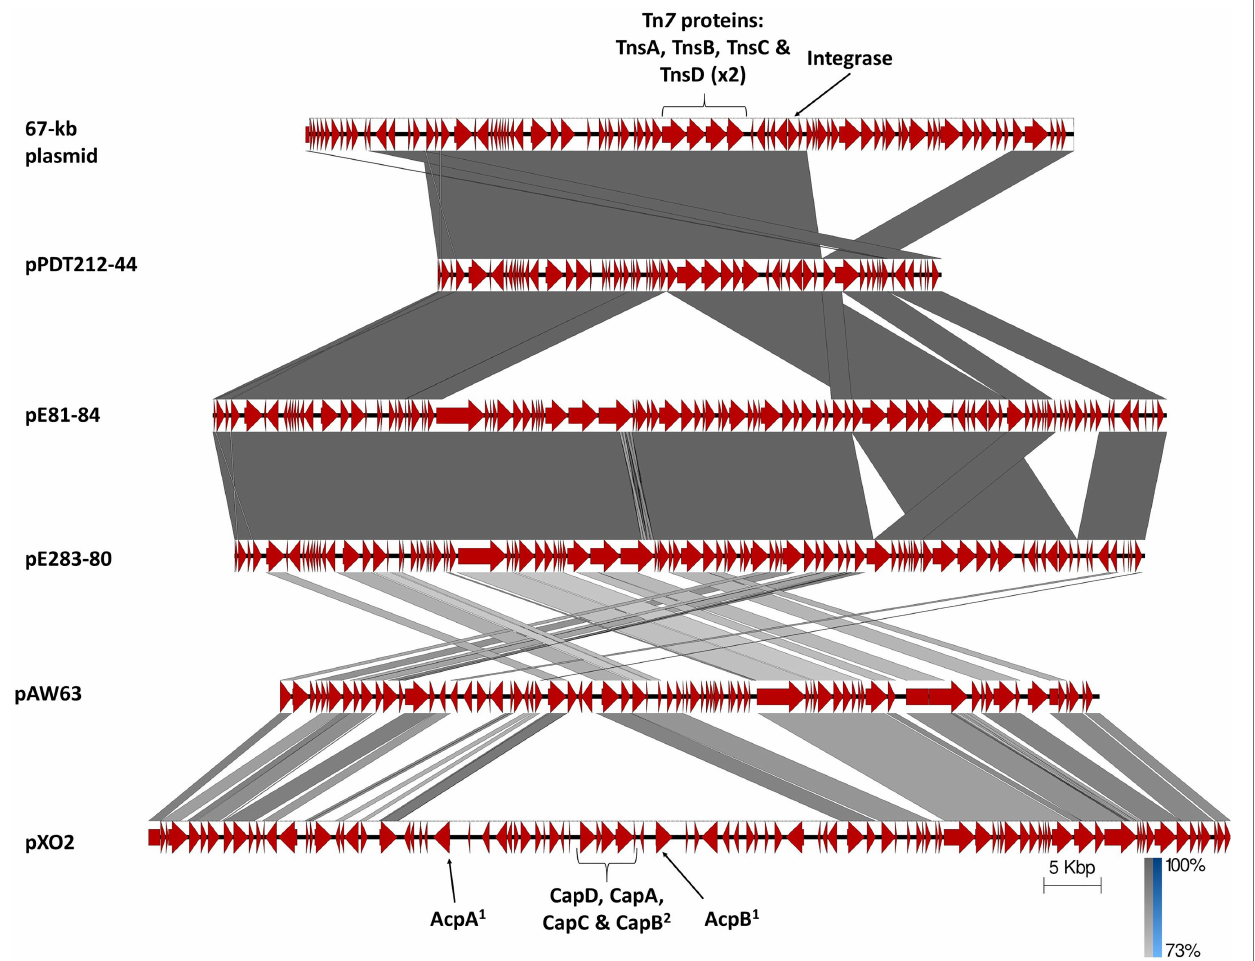
FIGURE 4 | Linear alignment of the 67-kb plasmid (Stevens et al., 2019), pPDT212-44, pE81-84, pE283-80 from B. cytotoxicus , pAW63 (DQ025752.1) from B. thuringiensis sv. kurstaki HD73, and pXO2 (NC_007323.3) from B. anthracis (Wilcks et al., 1999; Van der Auwera et al., 2005). CDSs are represented by block arrows. Relevant functions are annotated above or below the corresponding gene. Darkening gray shading reflects increasing nucleotide BLAST sequence identity. Scale and identity percentage are indicated in the lower right-hand corner. Numbers 1 and 2 at the bottom refer to the B. anthracis capsule production regulators and components,